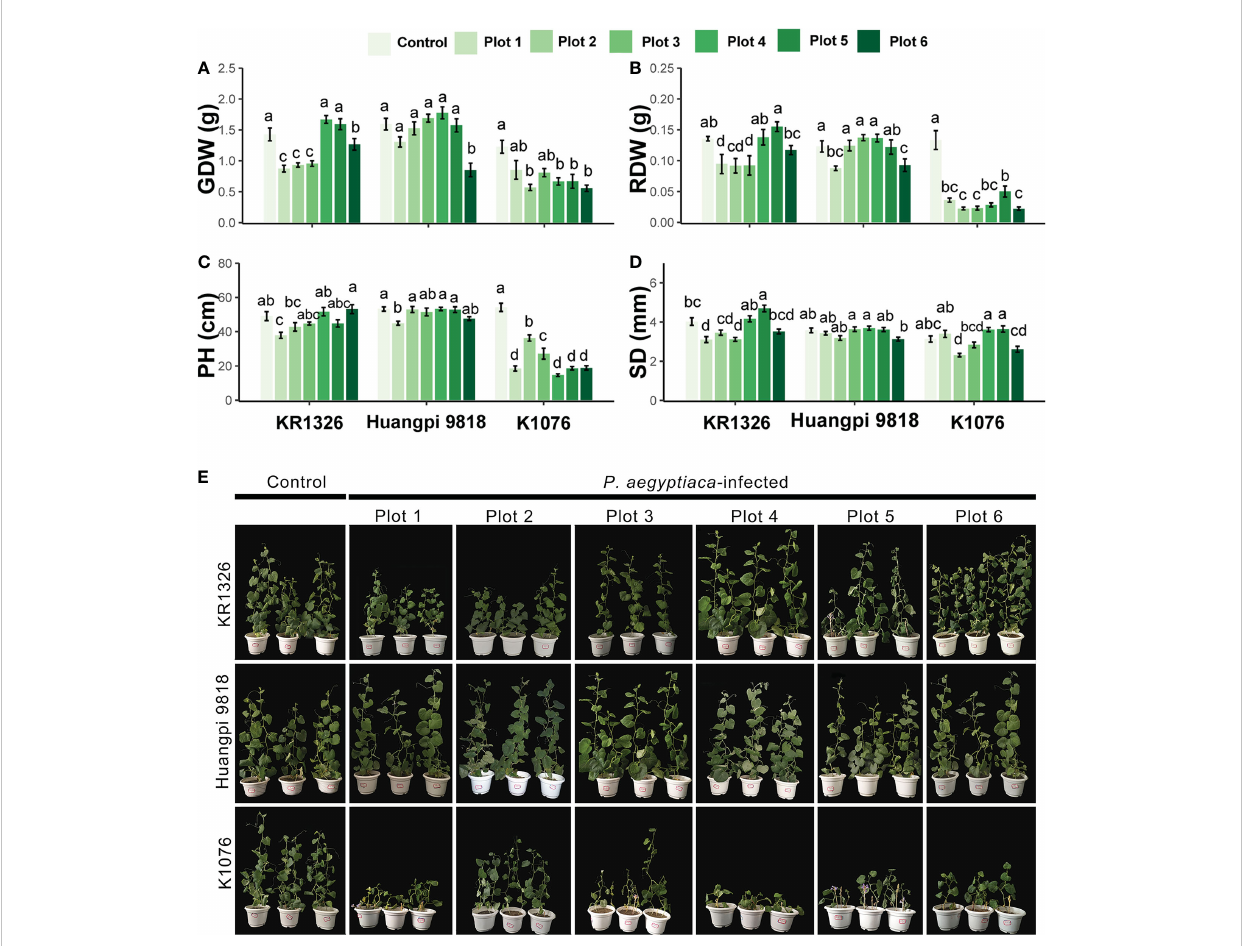
FIGURE 5 Effects of six P. aegyptiaca populations on the growth of different resistant melon cultivars. (A) Effects of P. aegyptiaca on melon total aboveground parts dry weight (GDW). (B) Effects of P. aegyptiaca on melon root dry weight (RDW). (C) Effects of P. aegyptiaca on melon plant height (PH). (D) Effects of P. aegyptiaca on melon stem diameter (SD). (E) Growth of melon after inoculation with or without broomrape from six populations. Vertical bars represent the mean ± SE, while letters represent mean separations at P ≤ 0.05 by Tukey ’ s HSD test ( n = 10 biological